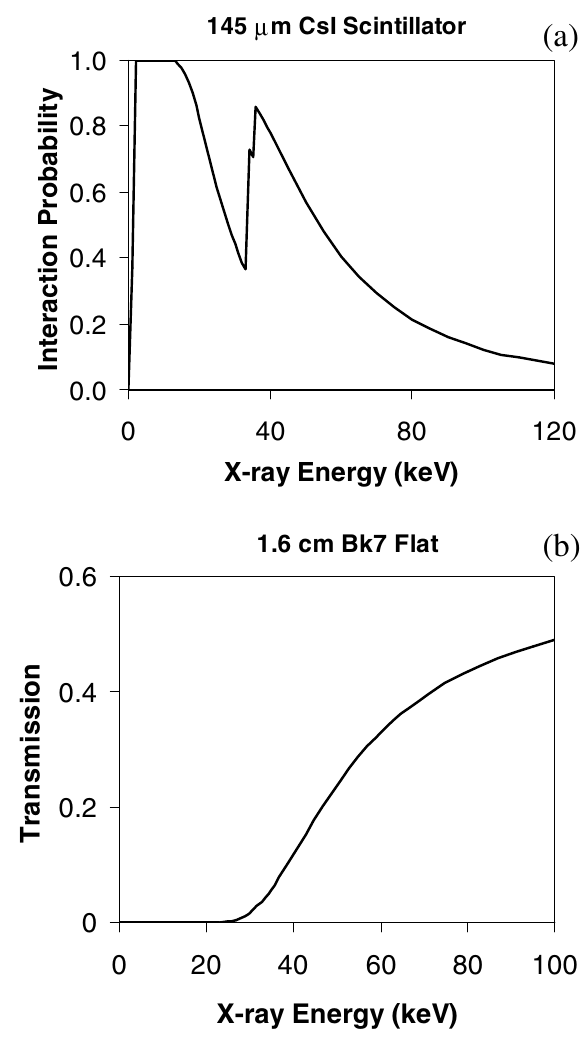
FIG. 5. Interaction probability vs x-ray energy for the CCD scintillator (a), and the transmission probability through the laser turning optic (b).